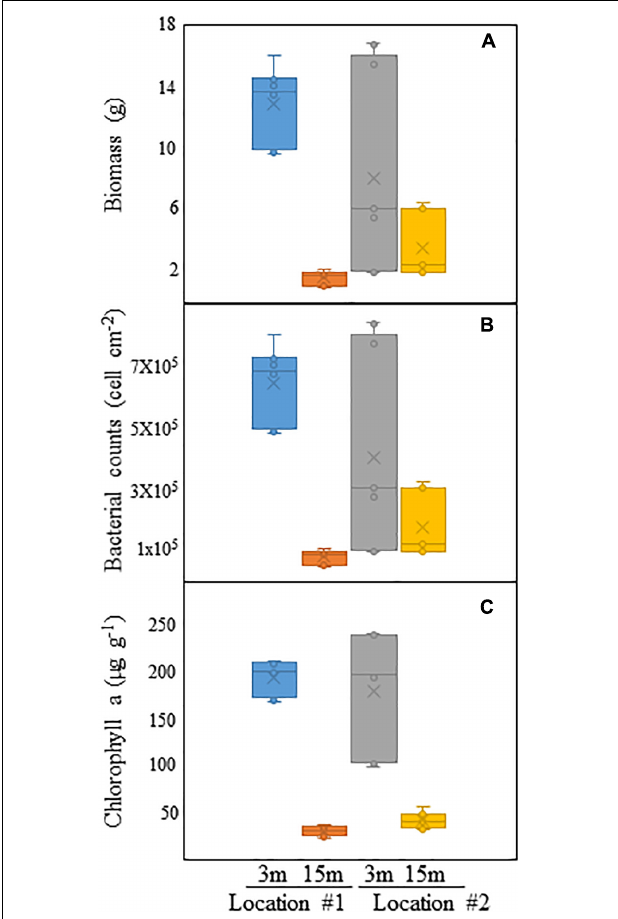
FIGURE 8 | Comparison of (A) total biomass (in g), (B) bacterial counts (in cells cm − 2 ) and (C) chlorophyll a concentration (in µ g g − 1 ) of biofouling communities developed on acrylic panels exposed at 3 and 15 m depth in Locations #1 and